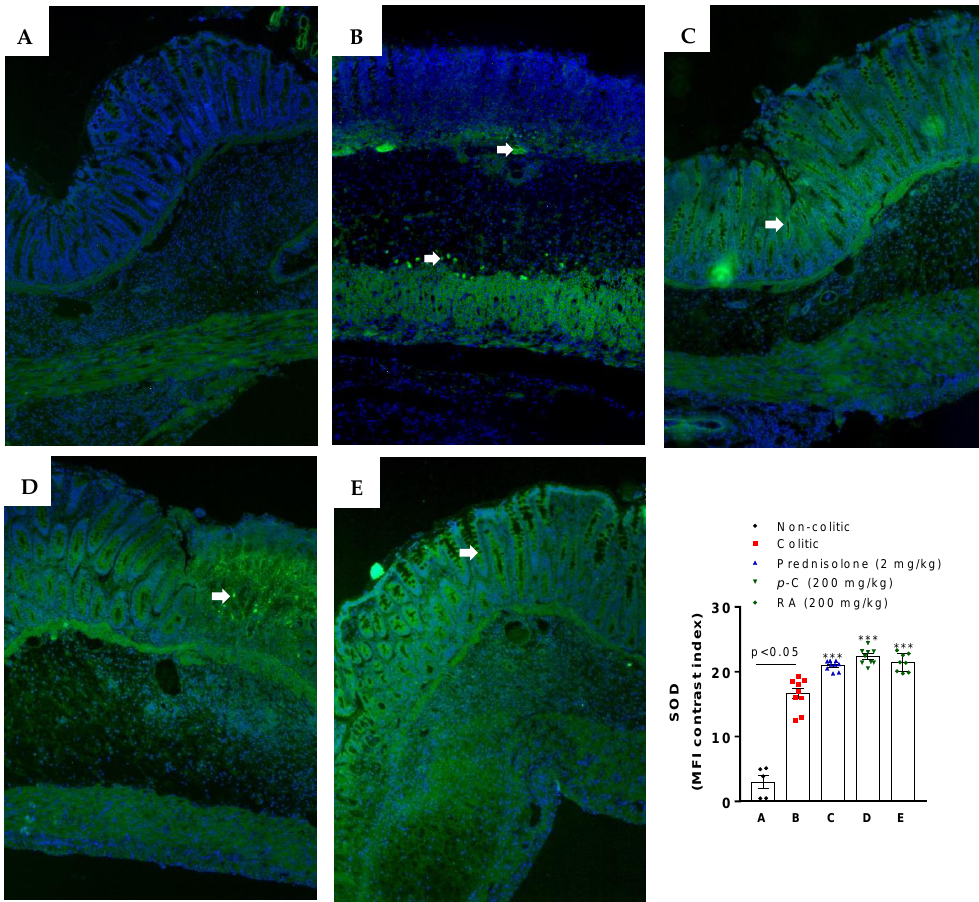
Figure 3. Representative photomicrographs of superoxide dismutase (SOD) with immunoreactivity marked in green (white arrows) and 4′,6-diamidino-2-phenylindole (DAPI) nuclear counterstained in blue from rats submitted to TNBS-induced ulcerative colitis. ( A ) Non-colitic group; ( B ) colitic group; ( C ) prednisolone (2 mg/kg); ( D ) p- C (200 mg/kg); ( E ) RA (200 mg/kg). Scale: 100 μm. Magnification: 400×. Data are expressed as mean ± standard error, having been analyzed by one-way ANOVA followed by Dunnett’s or Tukey’s test. *** p <0.001, compared to colitic control group ( n = 5–9 fields/3 per group). MFI: median fluorescence intensity.